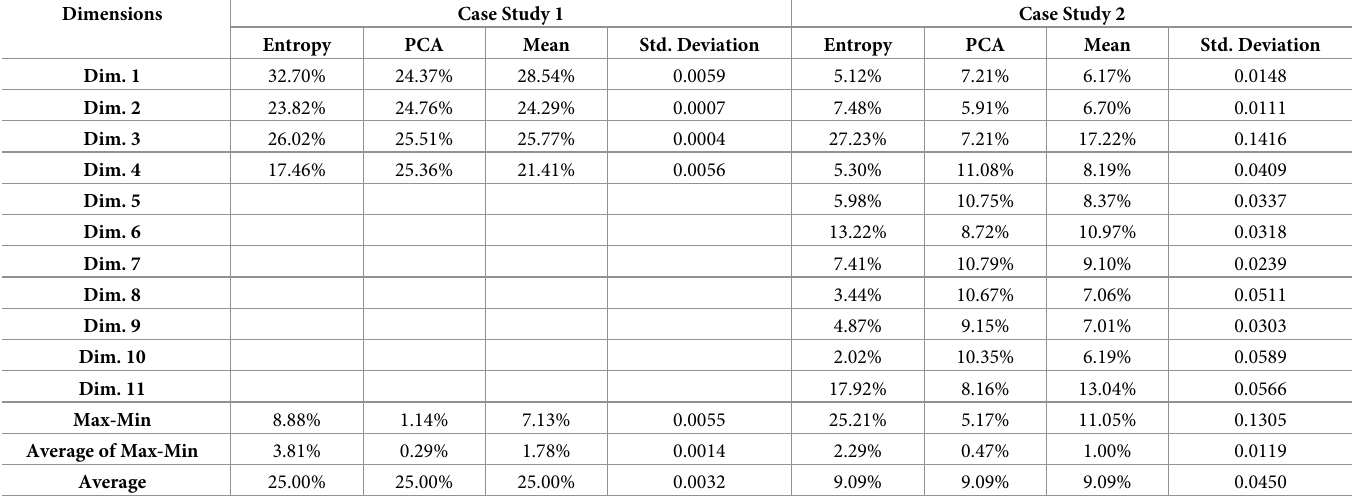
Table 10. Comparative analysis of the PCA and entropy